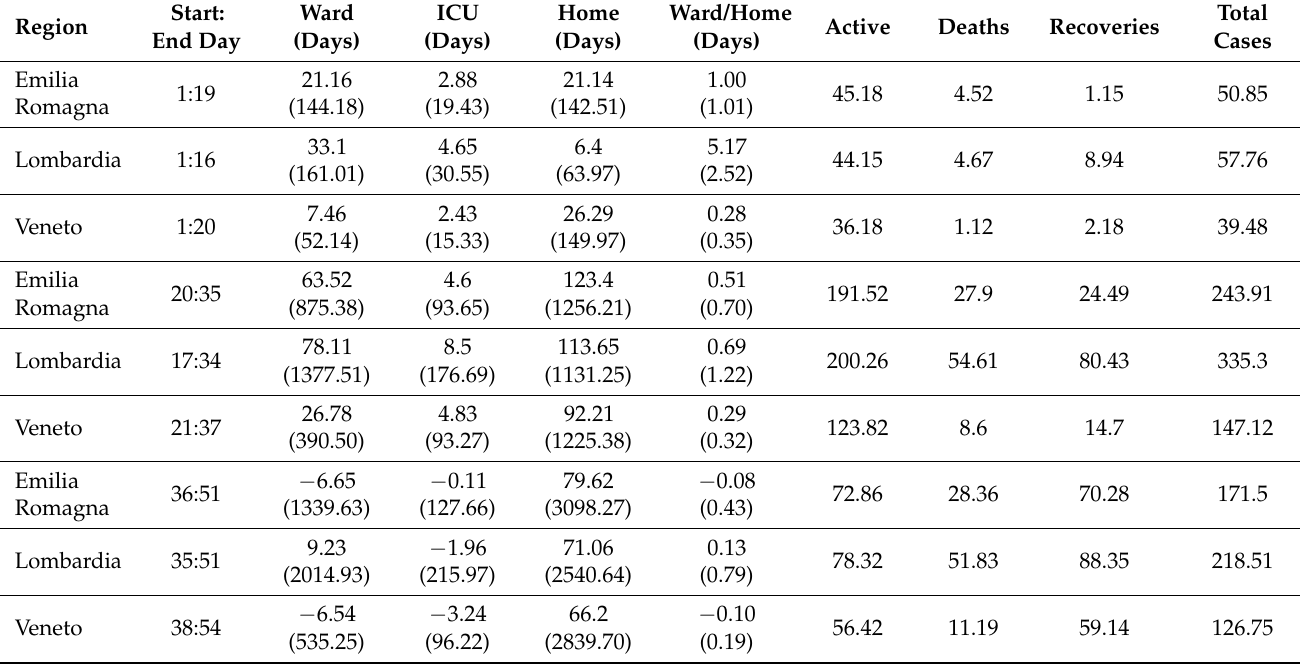
Table 1. Measures captured in Lombardia, Emilia Romagna, and Veneto during the three phases of the epidemic. Data are normalized per 100,000 inhabitants. In particular: number of patients treated in the hospital (ward), ICU and confined at home along with the relevant total number of days spent by the patients; the ratio between the number of ward and home cases; number of active cases, deaths and recoveries; cumulative number of